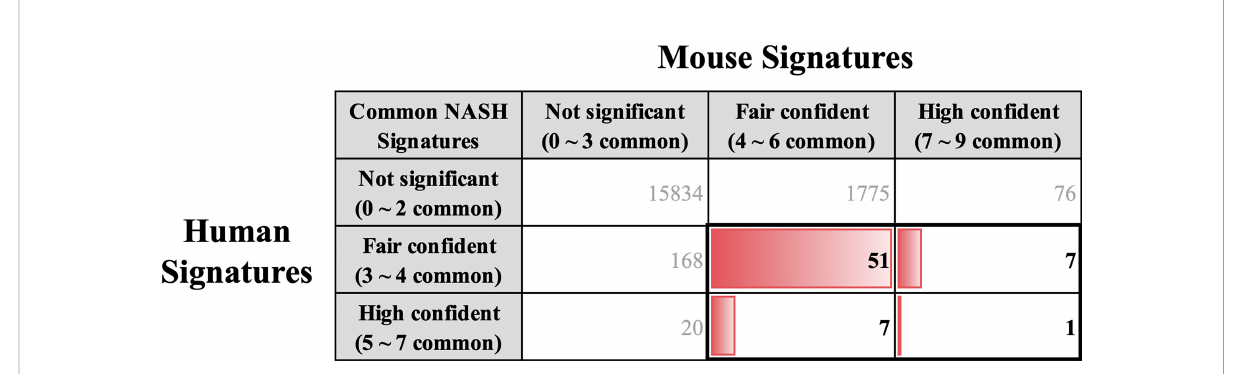
FIGURE 4 Key common hepatic signatures of human and mouse NASH. NASH signatures of humans and mice were coalesced using the BioMart orthologous gene annotation. Amongst the 254 human and 1,917 mouse NASH signatures, 66 genes (boxed with bold lines) were concordantly dysregulated between the two